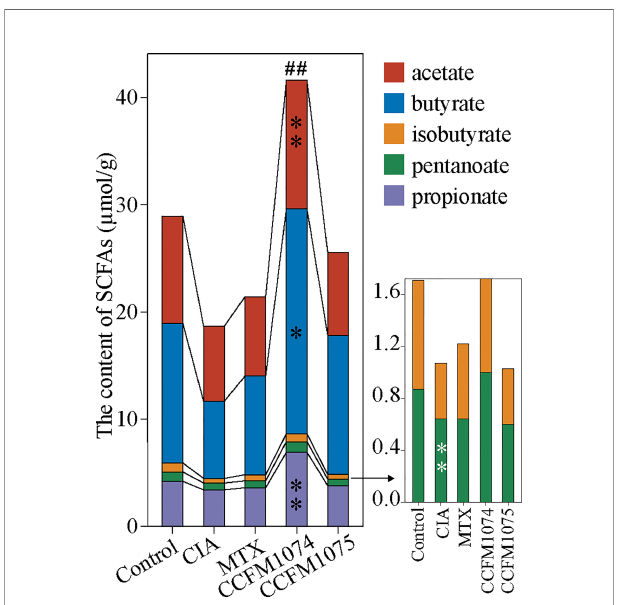
FIGURE 5 | Effects of L. casei on SCFAs production in CIA rats. control (vehicle-treated with saline 1.5 mL/day) group, CIA (vehicle-treated with saline 1.5 mL/day) group, methotrexate (MTX)-treated (6 mg/kg/week) group, CCFM1074 (treated with CCFM1074, 8.5 × 10 9 CFU/day) group and CCFM1075 (treated with CCFM1075, 8.5 × 10 9 CFU/day) group, eight rats per group. * p <0.05, ** p <0.01, ## p <0.01 (one-way ANOVA test with Dunnett ’ s multiple comparisons test). Black *, vs . CIA; white *, vs . Control; ## , vs . CIA (total